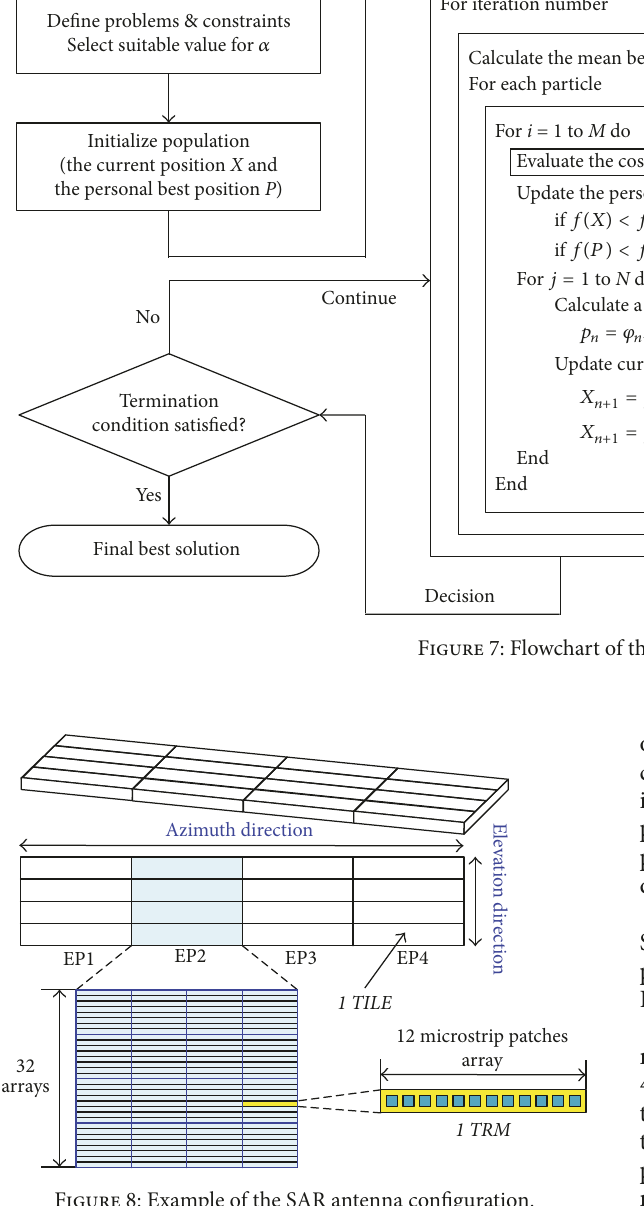
cost function was calculated with the far-field pattern and the mask template designed